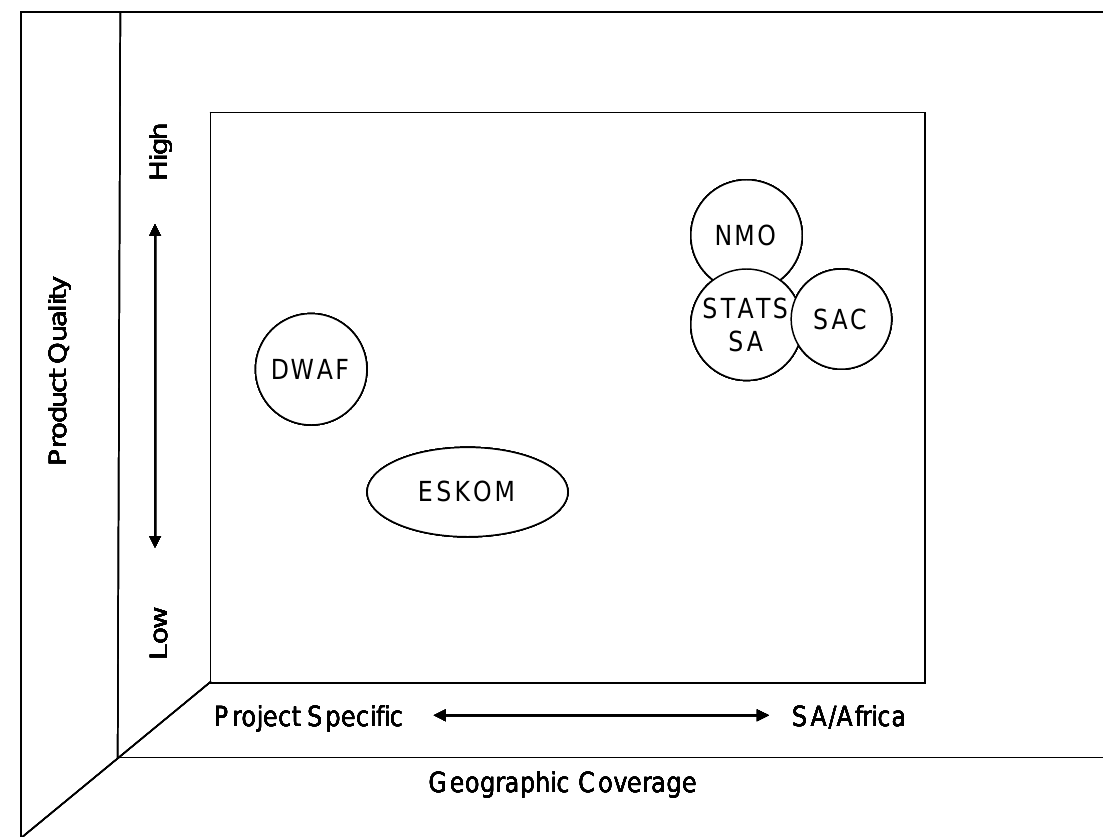
Figure 1: Strategic group map of public sector geospatial information